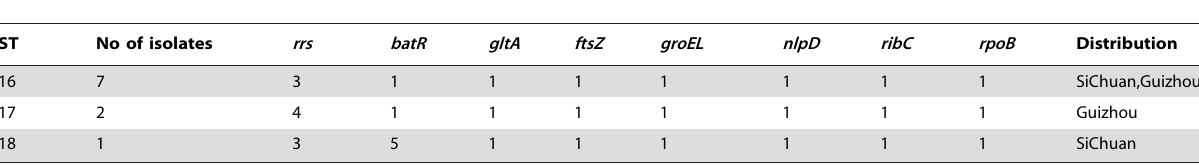
Table 1. Allele profile of new STs identifed in the present